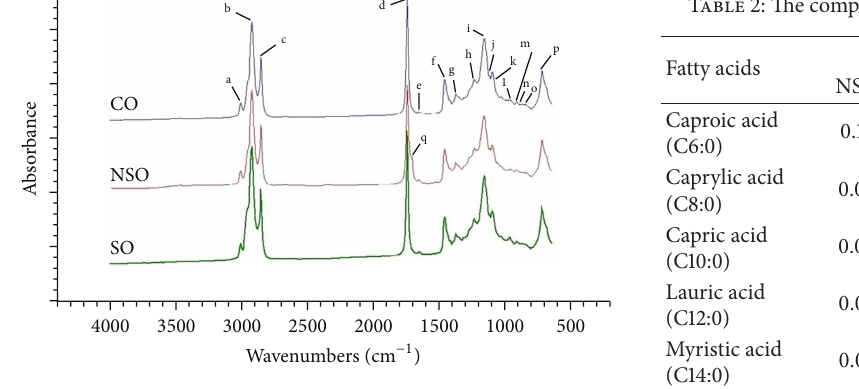
Figure 1: FTIR spectra of Nigella sativa L. seed oil, corn oil, and soybean oil at mid-infrared region range of 4000–650 cm −1 .